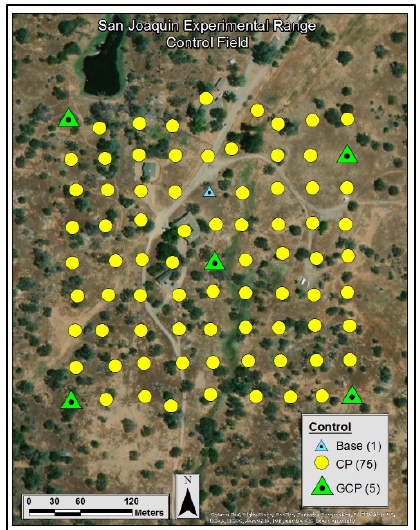
Figure 1: Site and ground control ponit and ground control point checkpoint